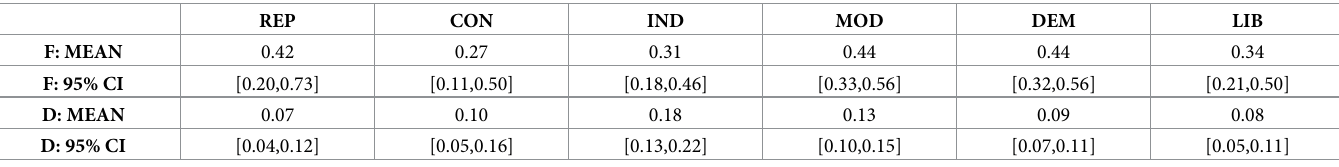
Table 4. Ambivalence parameters F and D broken down by party affiliation and political